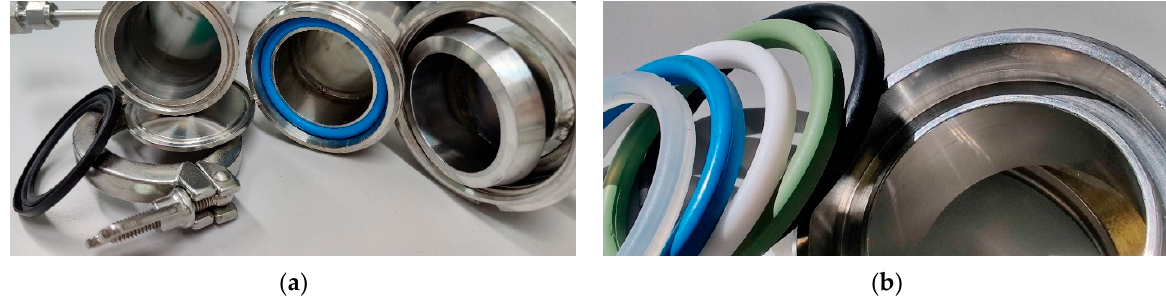
Figure 1. ( a ) Detail of the Clamp connection (Tri-clover-Tri-clamp) on the left versus DIN 11851 on the right; ( b ) Seals for DIN 11851 DN50 connection of different materials: Q/VMQ, NBR, PTFE, FKM/FPM and EPDM (left to